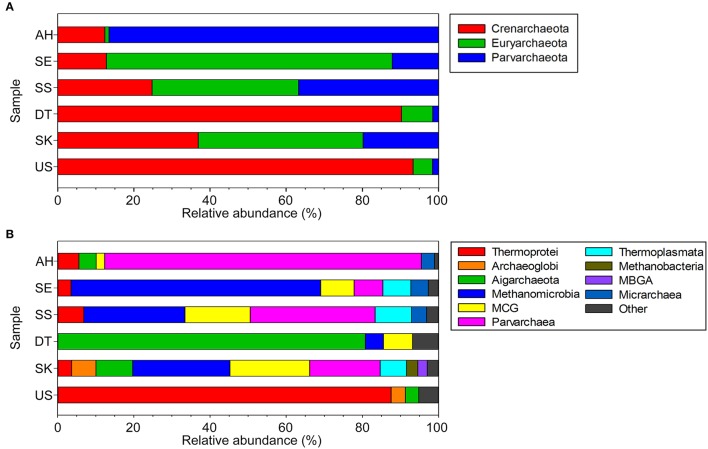
Relative abundance of archaeal 16S rRNA gene sequences. (A) Phyla and (B) class taxonomic levels of archaeal community structures with relative abundances of <2% were grouped as “Other.” Relative abundance is defined as the percentage of sequences in total successfully assignable sequences in the samples using Greengenes database.